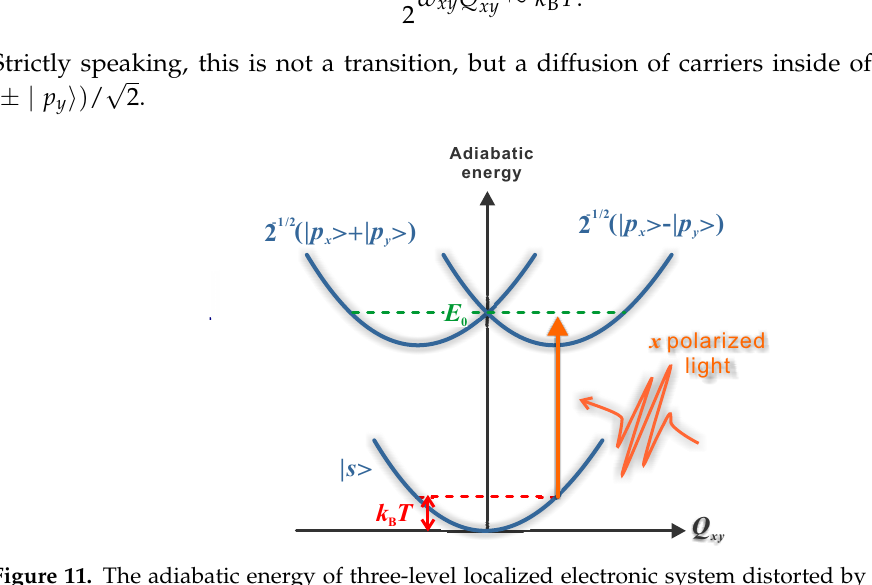
Figure 11. The adiabatic energy of three-level localized electronic system distorted by the thermal randomness of the phonon is given. For more details, see the